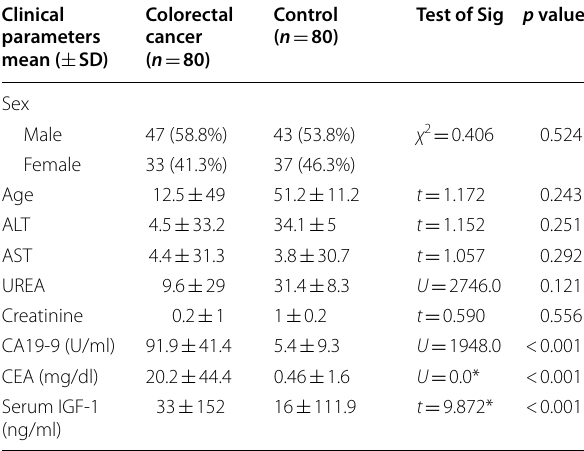
Table 1 Comparison between the two studied groups according to different parameters